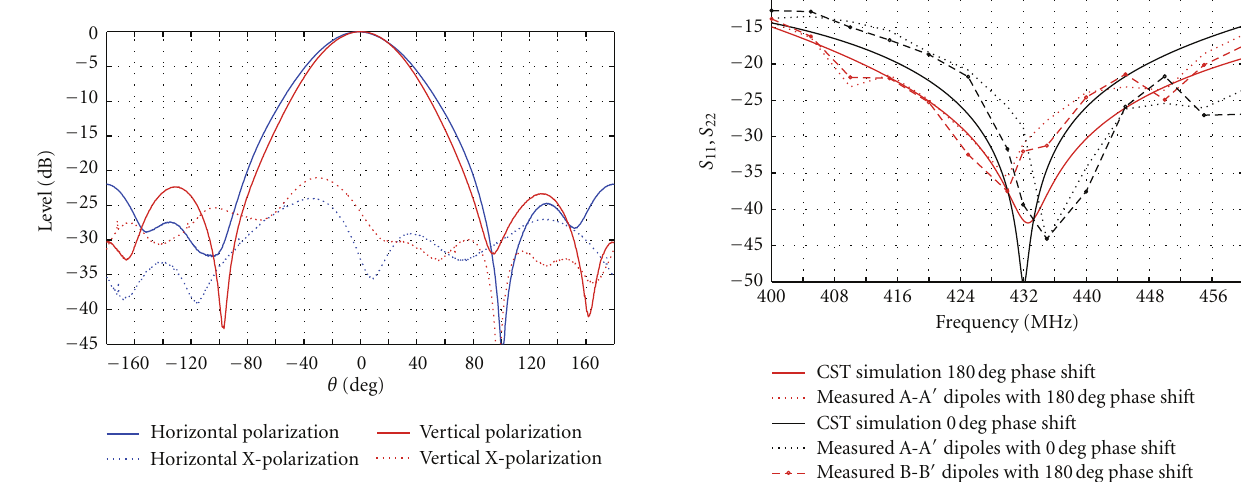
Figure 10: Measured pattern cut for horizontal (A dipoles) and vertical (B dipoles) polarization.